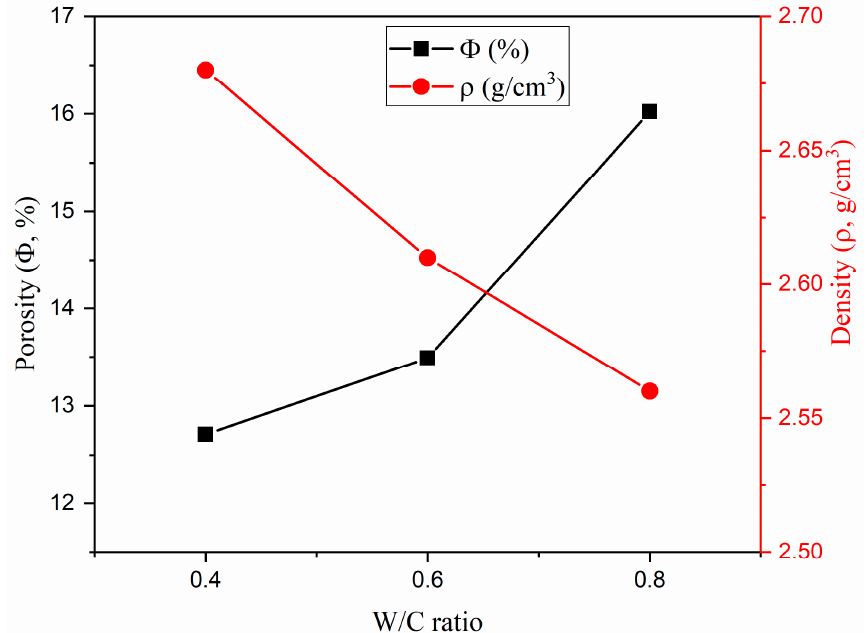
Figure 3. Effect of the W/C ratio on the density and porosity of the fabricated